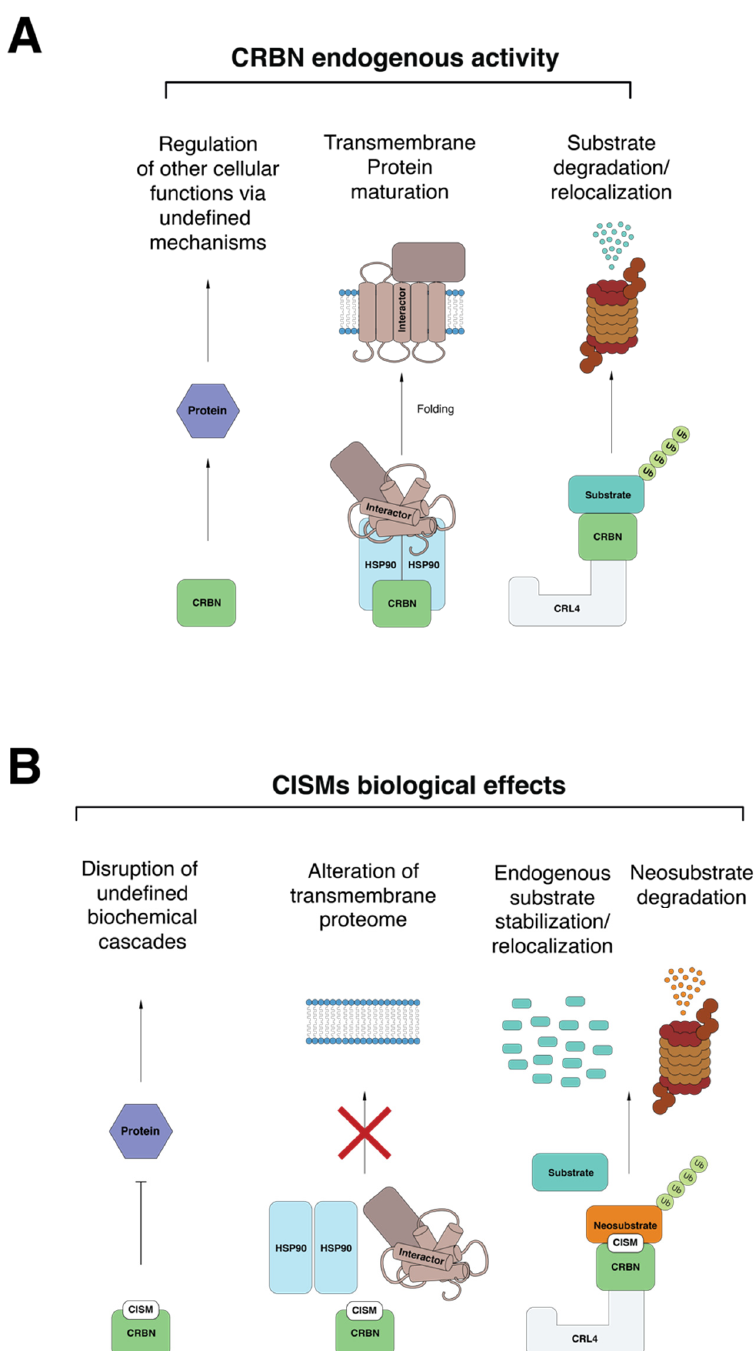
Figure 4. Intracellular pathways regulated by CRBN and potentially disrupted by treatment with CISMs. ( A ) CRBN interacts with the chaperone protein HSP90, augmenting the maturation of transmembrane proteins. CRBN is the adaptor of the E3 ligase CRL4 which engages proteins that are destined to the proteasome (e.g., MEIS2) or to other cell compartments (e.g., storage of BK Ca ++ channels in the endoplasmic reticulum). CRBN also regulates other pathways via undefined mechanisms (e.g., responses to oxidative stress). ( B ) In the presence of a CISM, CRBNs endogenous targets may be inhibited (e.g., inhibition to the response to reactive oxygen species, transmembrane protein maturation), hijacked to ubiquitinate neosubstrates for proteasomal degradation (e.g., IKZF1, IKZF3) or accumulate in non-physiological cell compartments (e.g., redirection of BK Ca ++ channels to surface membrane).